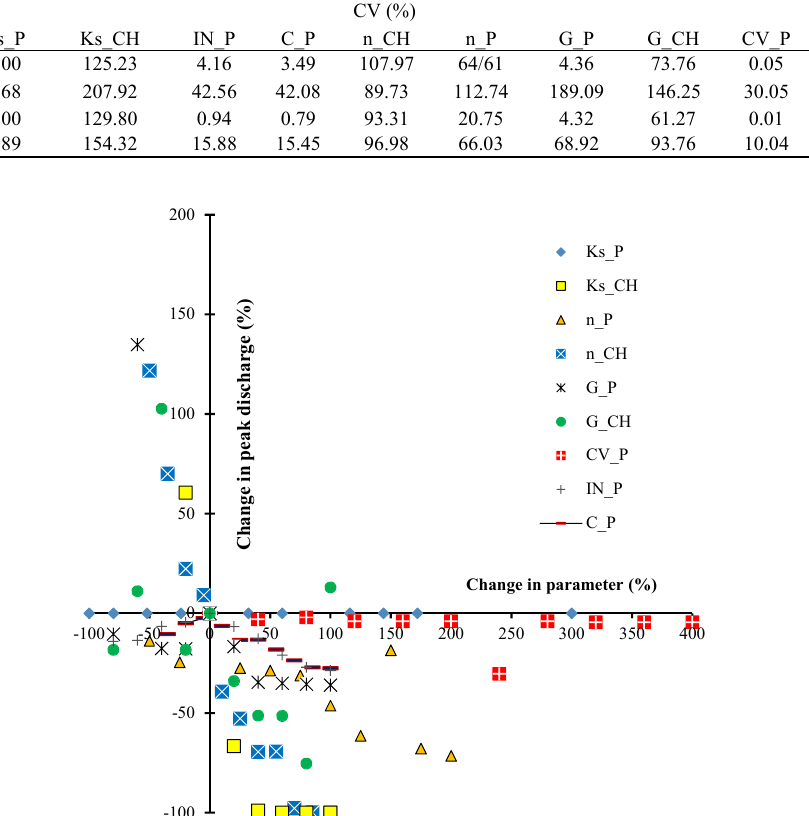
Fig. 3: Changes in peak discharge with the changes of chosen parameters